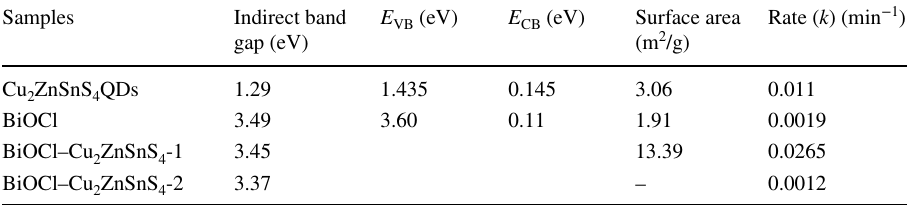
gap energy and surface area of prepared BiOCl microspheres, Cu 2 ZnSnS 4 QDs and BiOCl–